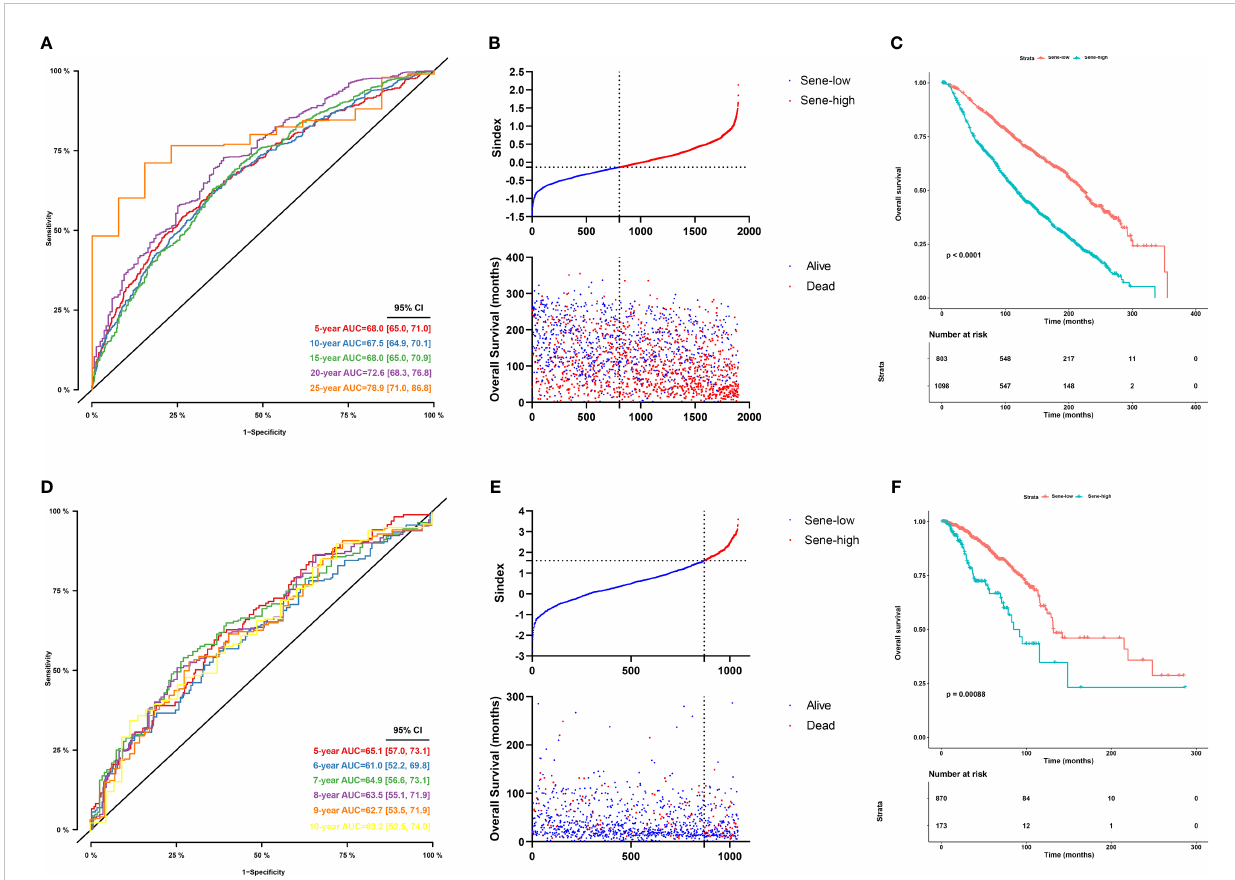
FIGURE 6 Evaluation of the performance of the senescence-based Sindex in METABRIC dataset and external validation in the TCGA-BRCA datasets. (A) Time- dependent ROC for 5-, 10 -,15-,20- and 25-year predictions of overall survival for the Sindex in the METABRIC dataset. (B) Relationship between the Sindex (upper), and the survival status of patients in different senescence subtype (bottom) in METABRIC dataset. (C) Kaplan-Meier survival curves of the Sindex. Patients from the METABRIC dataset are strati fi ed into two groups according to the optimal cut-off values for the Sindex. (D) Time- dependent ROC for 5-, 10 -,15-,20- and 25-year predictions of overall survival for the Sindex in the TCGA-BRCA dataset. (E) Relationship between the Sindex (upper), and the survival status of patients in different senescence subtype (bottom) in TCGA-BRCA dataset. (F) Kaplan-Meier survival curves of the Sindex. Patients from the TCGA-BRCA dataset are strati fi ed into two groups according to the optimal cut-off values for the